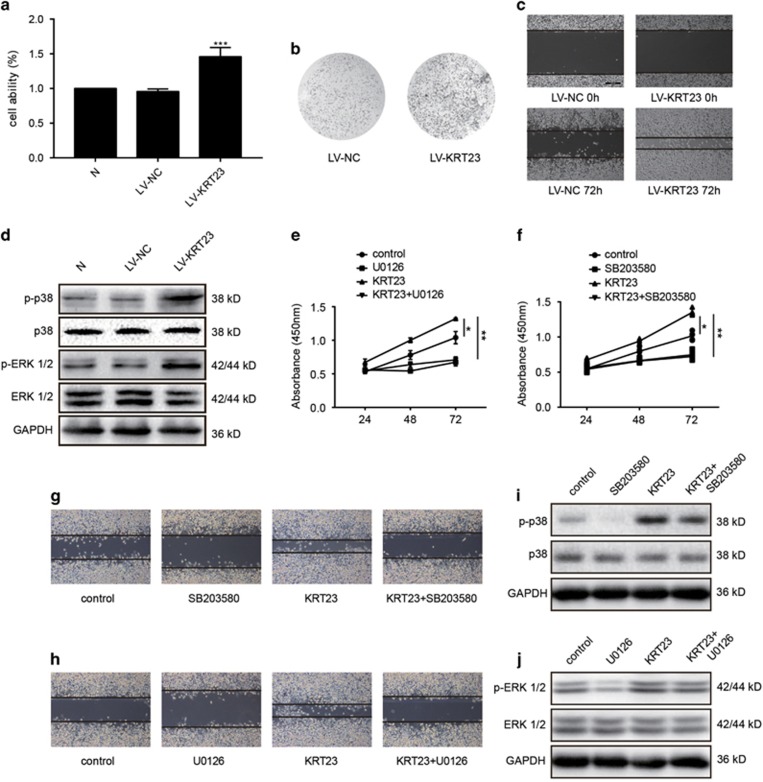
Overexpression of KRT23 promoted proliferation and migration in RKO CRC cells. (a) Cell viability was analyzed by MTT in RKO cells that were infected with or the NSP LV-NC. (b) Colony formation assay of RKO cells infected with LV-KRT23 or the NSP LV-NC. (c) Cell migration was analyzed by a wound-healing assay. RKO cells were seeded in 6-well plates and grown to full confluence (50 ×). (d) The phosphorylated and total ERK and p38 levels in RKO cells infected with LV-KRT23 were measured by a western blot assay using antibodies against p-p38, p38, p-ERK and ERK. (e) Cell viability was analyzed by CCK-8 in RKO cells that were treated with U0126 and/or LV-KRT23. (f) Cell viability was analyzed by CCK-8 in RKO cells that were treated with SB203580 and/or LV-KRT23. (g) Cell migration was analyzed by a wound-healing assay. RKO cells were treated with SB203580 and/or LV-KRT23. (h) Cell migration was analyzed by a wound-healing assay. RKO cells were treated with U0126 and/or LV-KRT23. (i) The phosphorylated and total p38 levels in RKO cells treated with SB203580 and/or LV-KRT23 were measured by a western blot assay using antibodies against p-p38 and p38. (j) The phosphorylated and total ERK 1/2 levels in RKO cells treated with U0126 and/or LV-KRT23 were measured by a western blot assay using antibodies against p-ERK 1/2 and ERK 1/2 (*P<0.05, **P<0.01 and ***P<0.001)